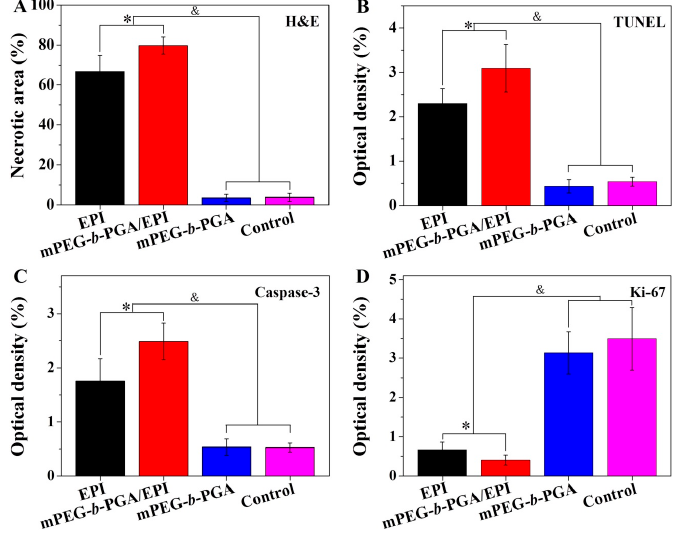
Figure 12. Relative necrotic areas of tumor sections from H&E staining ( A ), and relative optical densities of tumor sections from TUNEL assay ( B ), cleaved caspase-3 ( C ), and Ki-67 analyses ( D ) after treatment of free EPI, mPEG- b -PGA/EPI, mPEG- b -PGA, or NS as control. Data were presented as mean ± SD ( n =3; * p < 0.05, & p < 0.001).